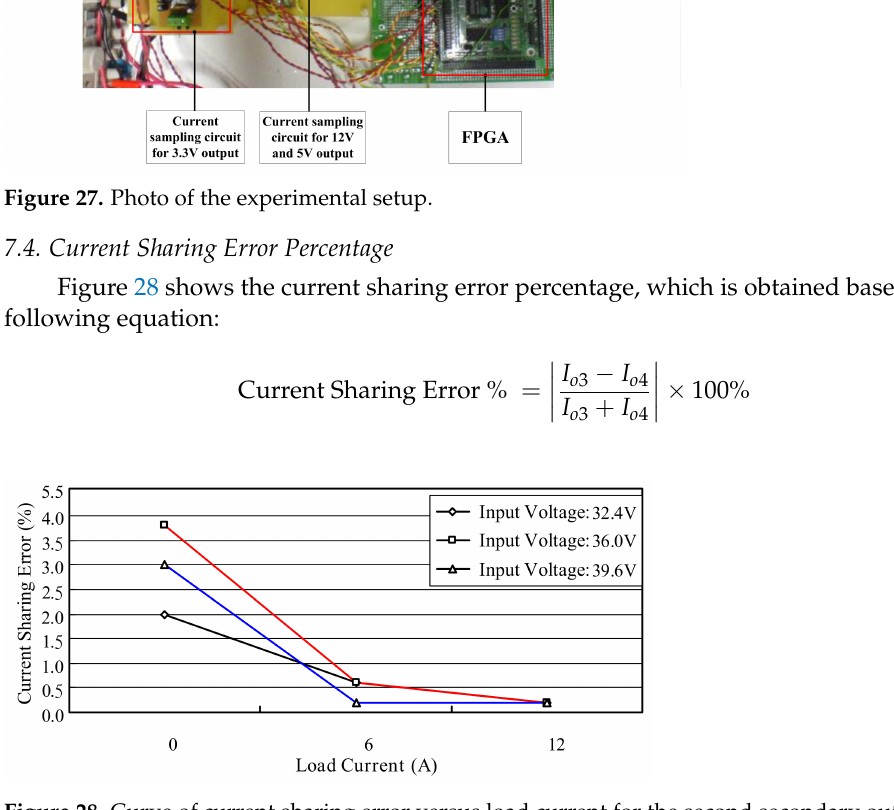
Figure 28. Curve of current sharing error versus load current for the second secondary